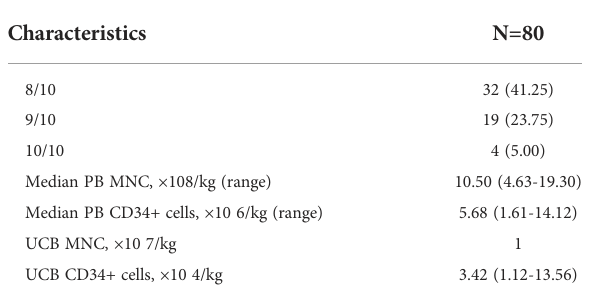
TABLE 1 Characteristics of patient and